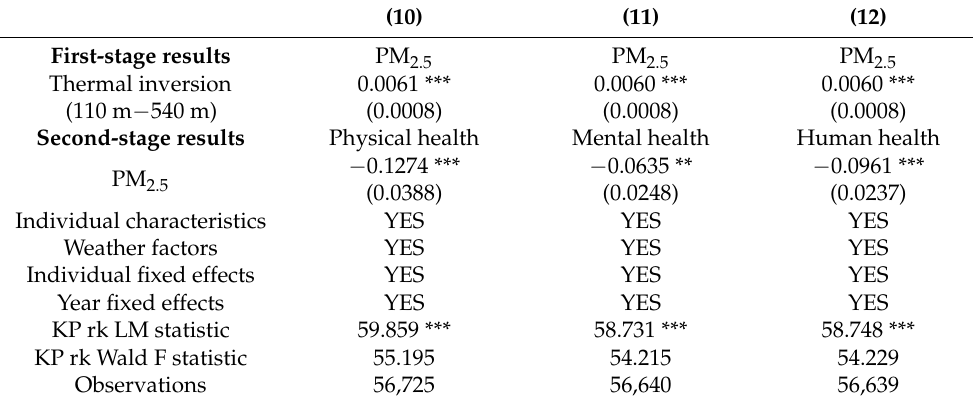
Table 5. Replacing the